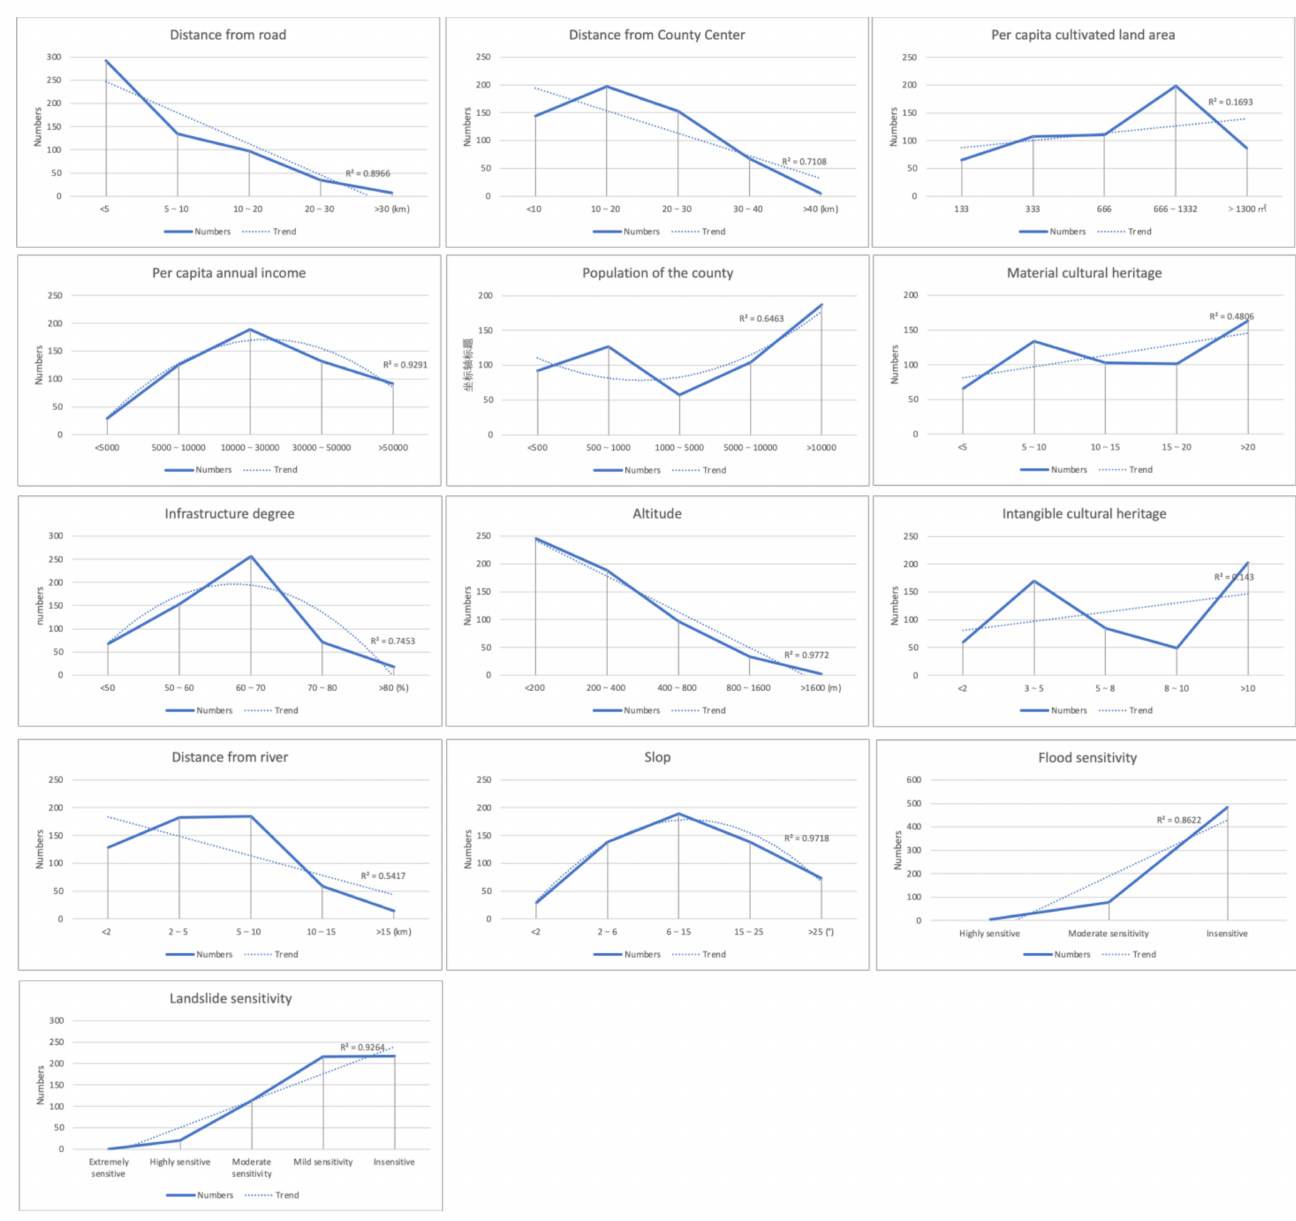
Figure 5. Hierarchical analysis of ethnic minority villages in Fujian Province based on various influencing